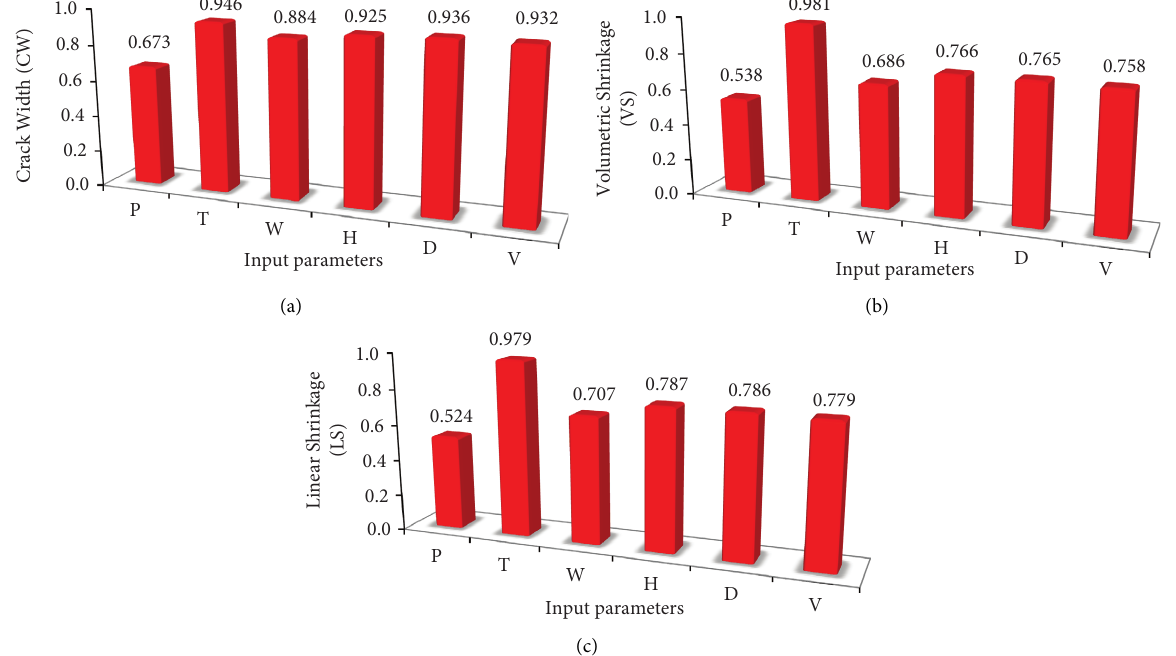
Figure 18: Sensitivity analysis to determine the impact of each data on the output for (a) crack width (CW), (b) volumetric shrinkage (VS), and (c) linear shrinkage